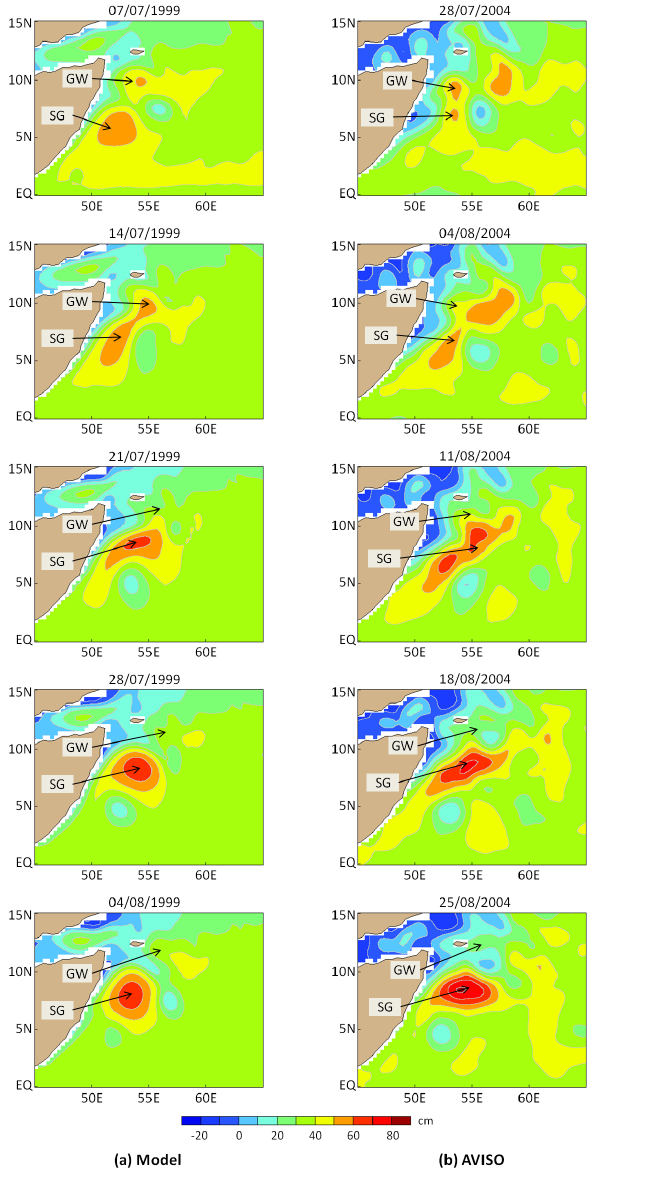
Figure 14. Sequences of patterns of a proxy of the relative vorticity from (a) model simulation S12-1 outputs sampled on the Aviso grid, and (b) Aviso altimeter data. The vorticity proxy is calculated as the adimensionalized Laplacian of the 7-day snapshots of SSH shown in Fig. 13 (see text). Arrows indicate the location of the Southern Gyre (SG) and the Great Whirl (GW) determined in (a) using the vorticity and spiciness of the model at full resolution, and in (b) to suggest a possible collision